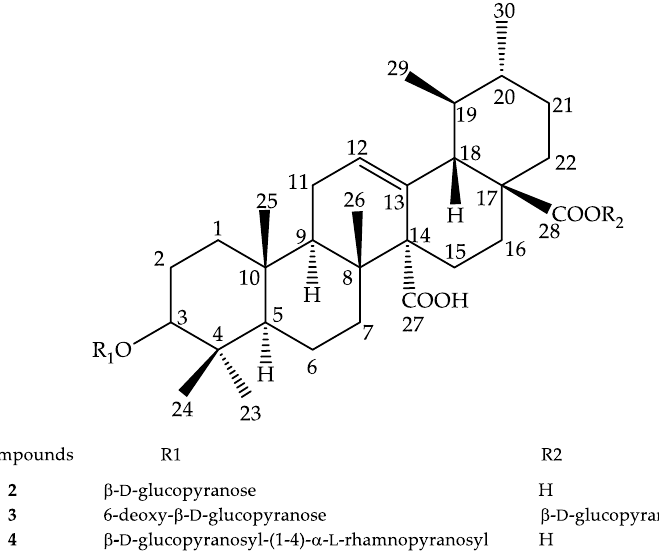
Figure 4. The triterpenoid glycosides obtained from M. inermis roots.